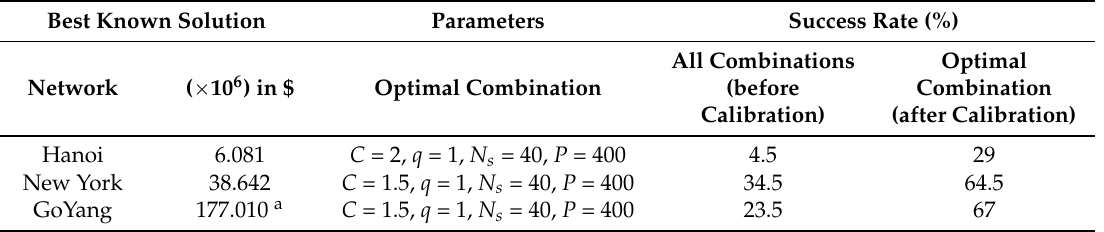
Table 4. Comparison between the success rate before and after the parameter calibration. Best Known